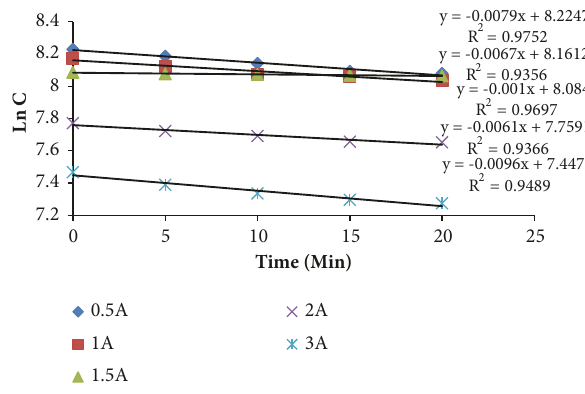
Figure 9: First-order kinetics for